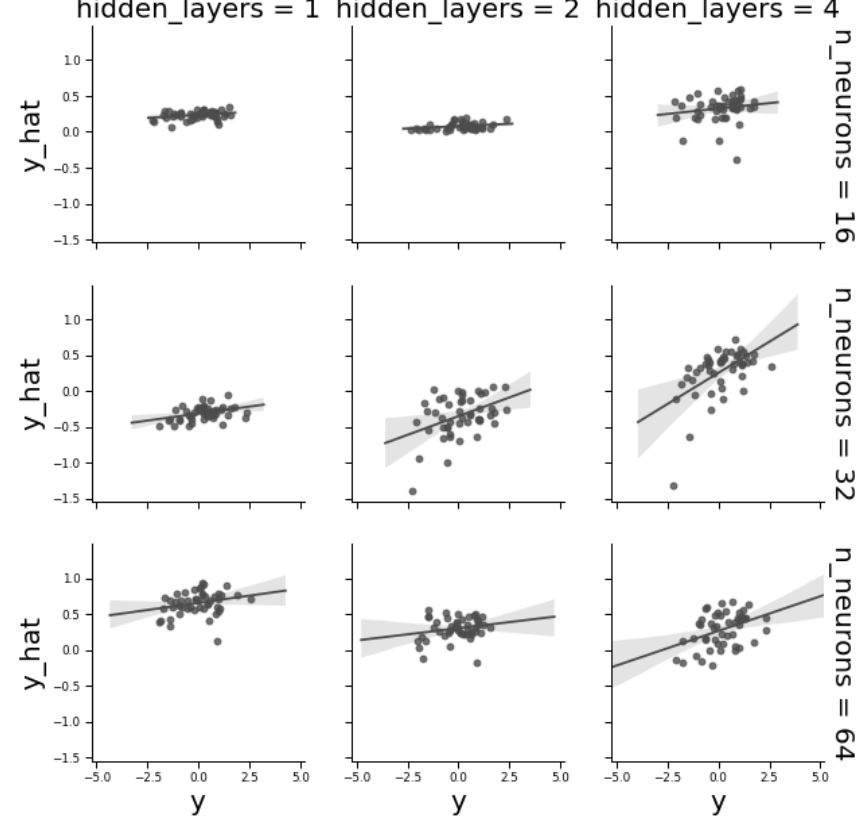
Figure 5. Correlations between observed and predicted phenotypes in the validation dataset as a function of the number of layers and of number of neurons per layer for the CYMMIT wheat data. Each dot corresponds to a single phenotype in the validation dataset. The best combination was 32 neurons and four hidden layers (correlation = 0.55).